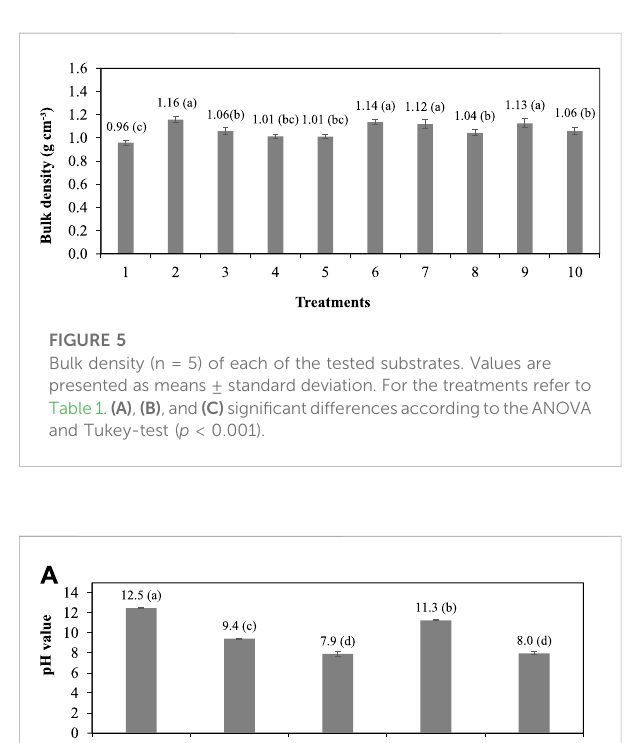
FIGURE 6 pH values (pH; n = 5) (A) , electrical conductivity (EC; n = 5) (B) , and volume reduction (VR; n = 10) (C) of the tested substrates. Values are presented as means ± standard deviation. (A) , (B) , (C) and (D) signi fi cant differences according to the ANOVA and Tukey-test ( p <